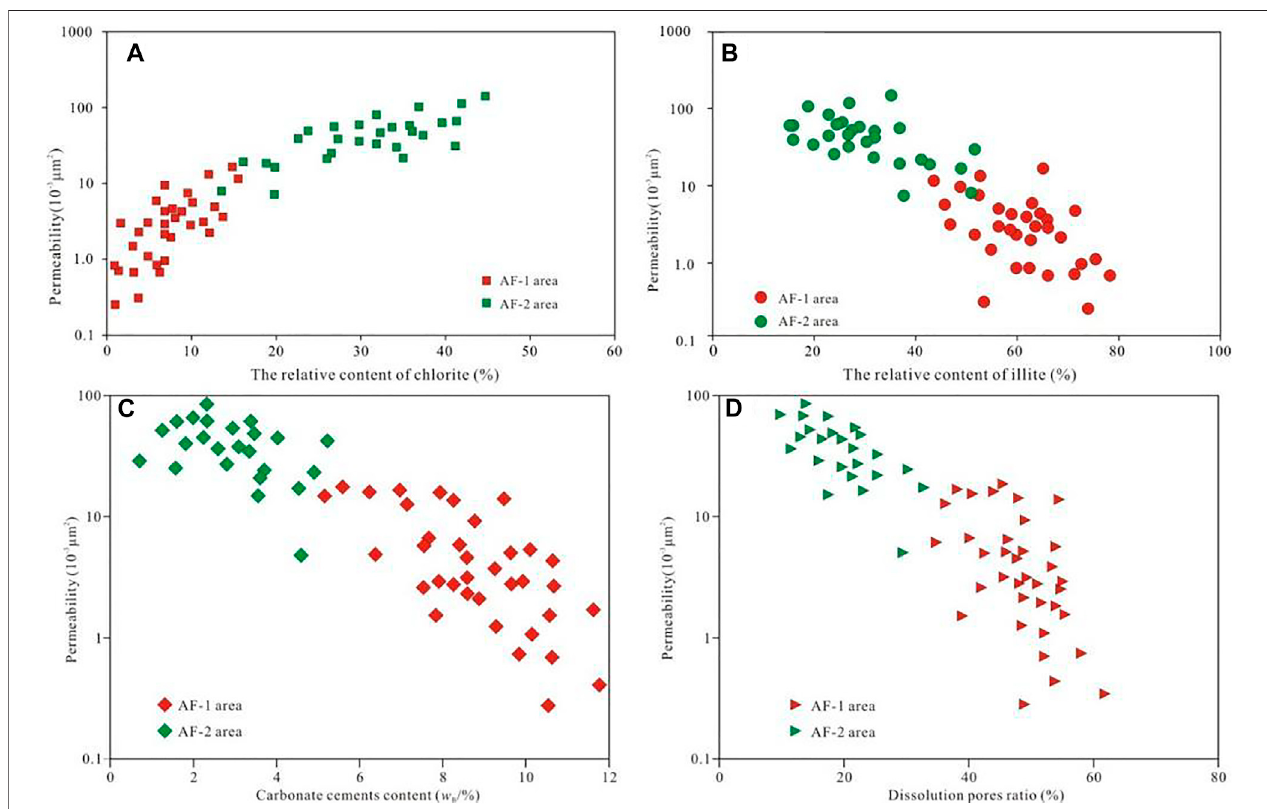
FIGURE 13 | Correlation between permeability and (A) relative content of chlorite, (B) relative content of illite, (C) carbonate cements content, and (D) dissolution pores ratio in the Huangliu sandstones.